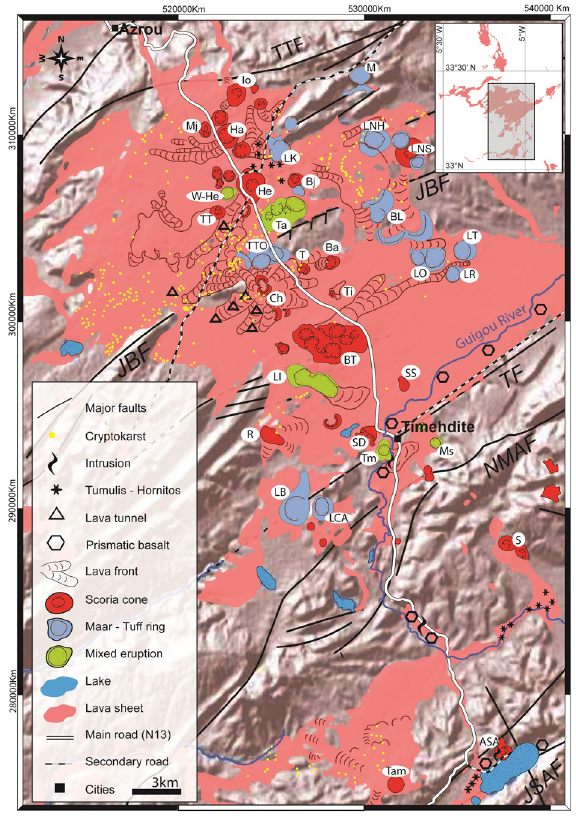
Fig. 2. Map of the main volcanic features on both tabular and folded domain of the central Middle- Atlas